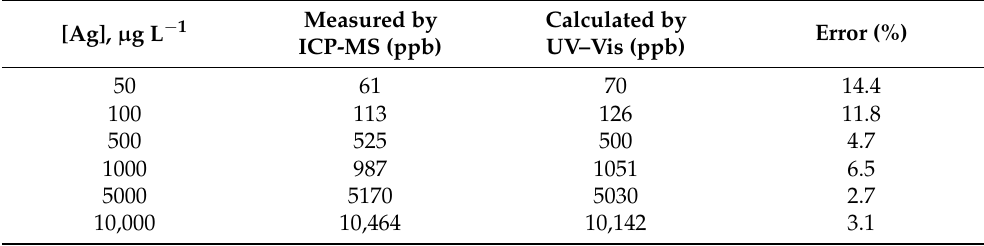
Table 4. Comparison of concentration of PVP-AgNP measured by ICP-MS and